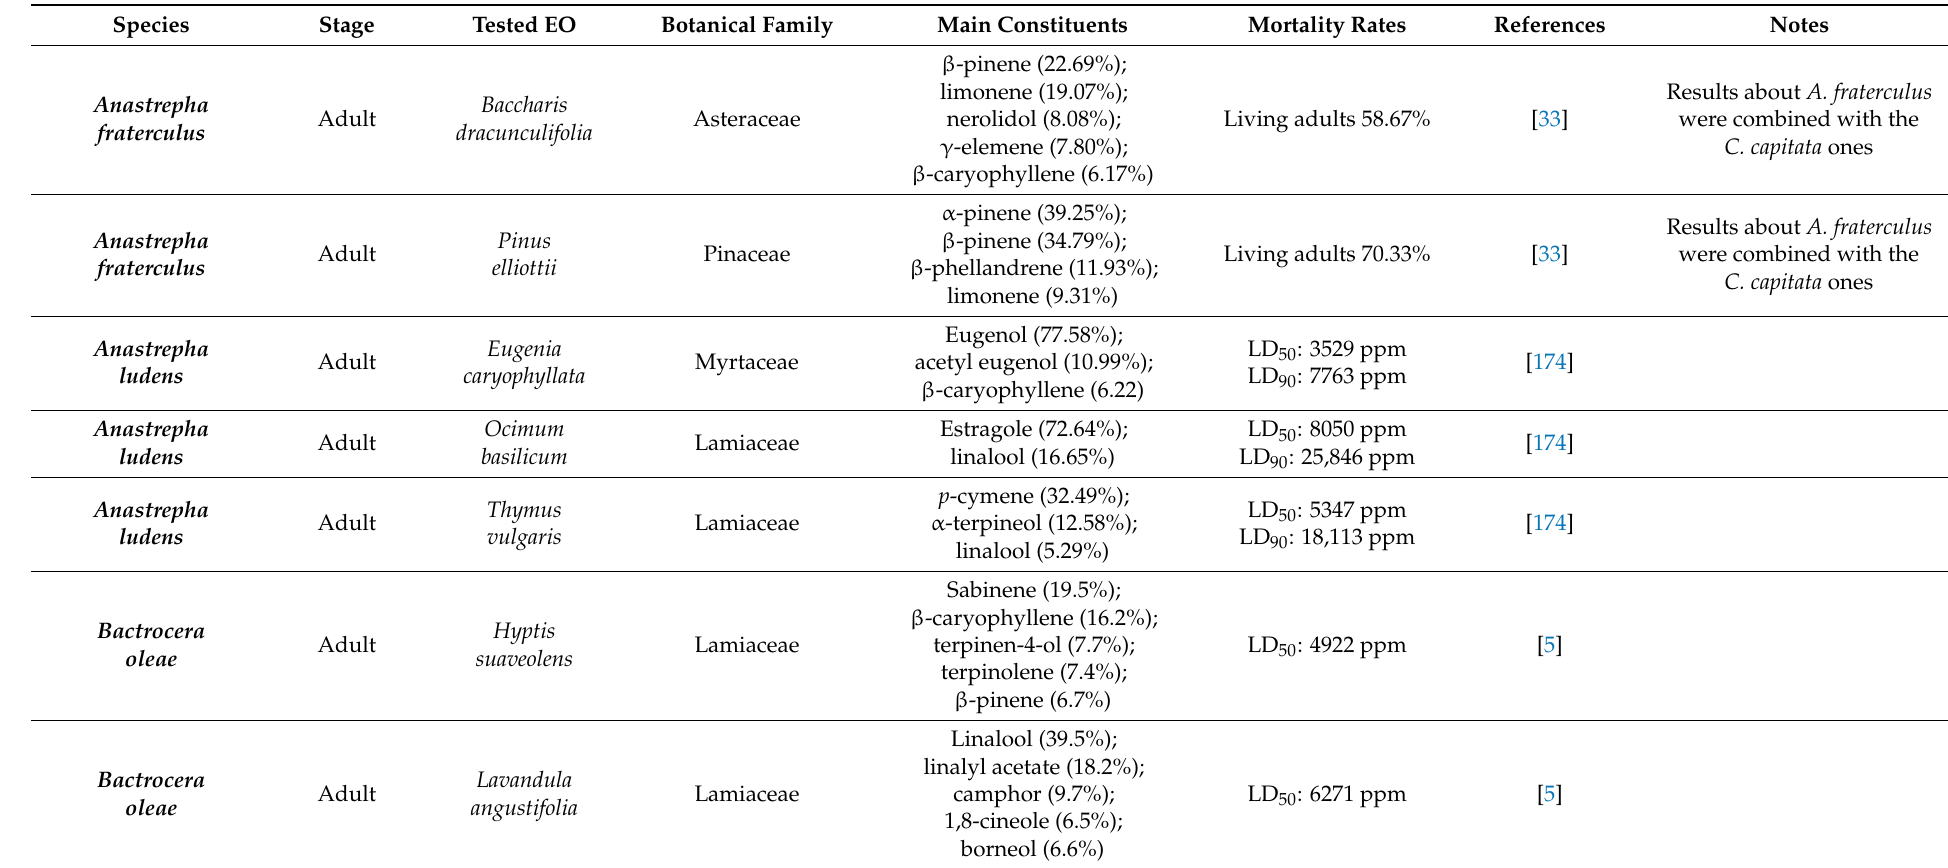
Table 6. Essential oils (EOs) were examined for ingestion toxicity against immature and adult stages of Tephritidae flies. In addition to mortality, the percentage of main compounds of tested EOs is